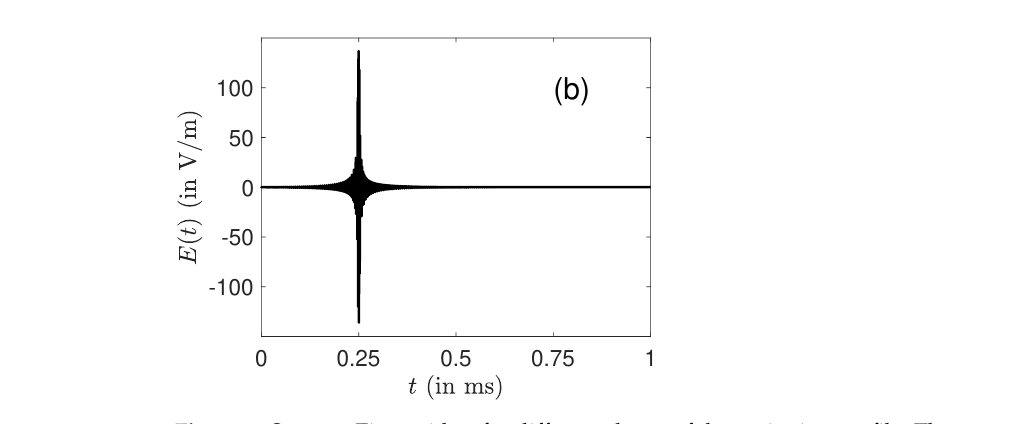
Figure 2. Same as Figure 1 but for different slopes of the excitation profile. The parameter a is fixed, respectively, to 0.25 and 0.75 in ( a , b ). The optimal pulses without RWA are represented.